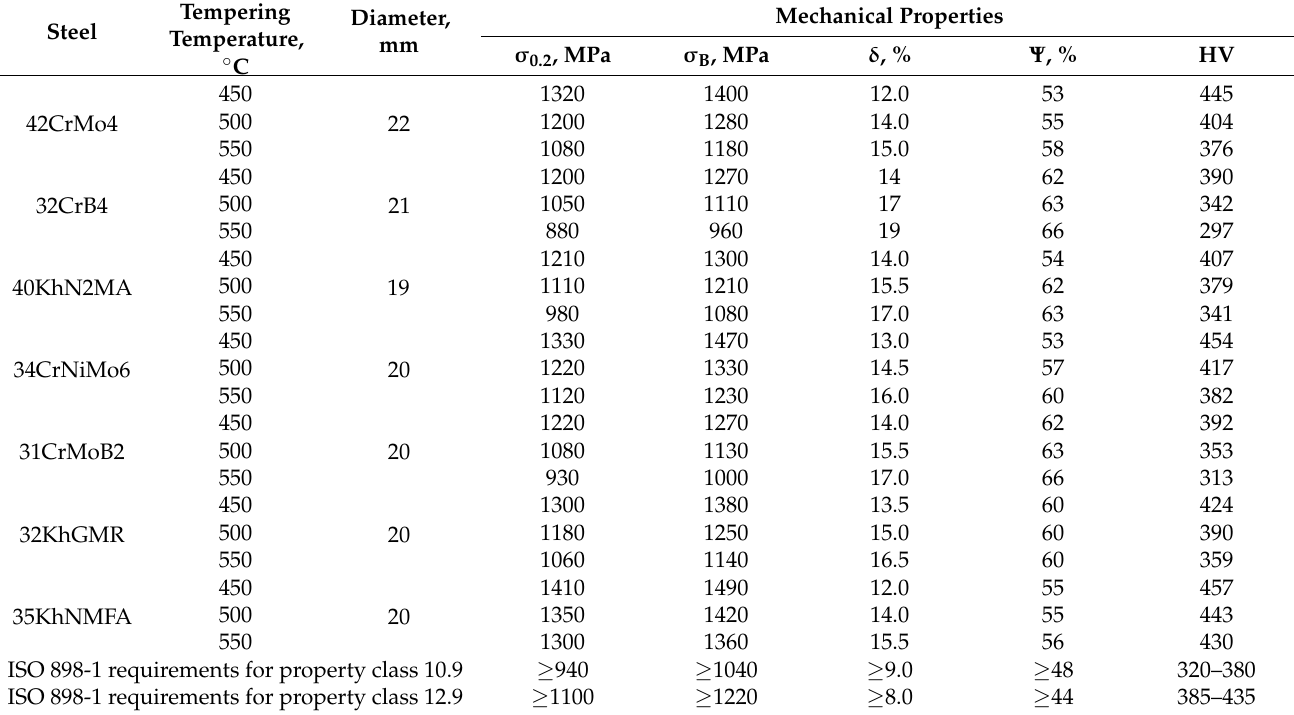
Table 5. Mechanical properties of hot-rolled round bars after quenching and tempering at various